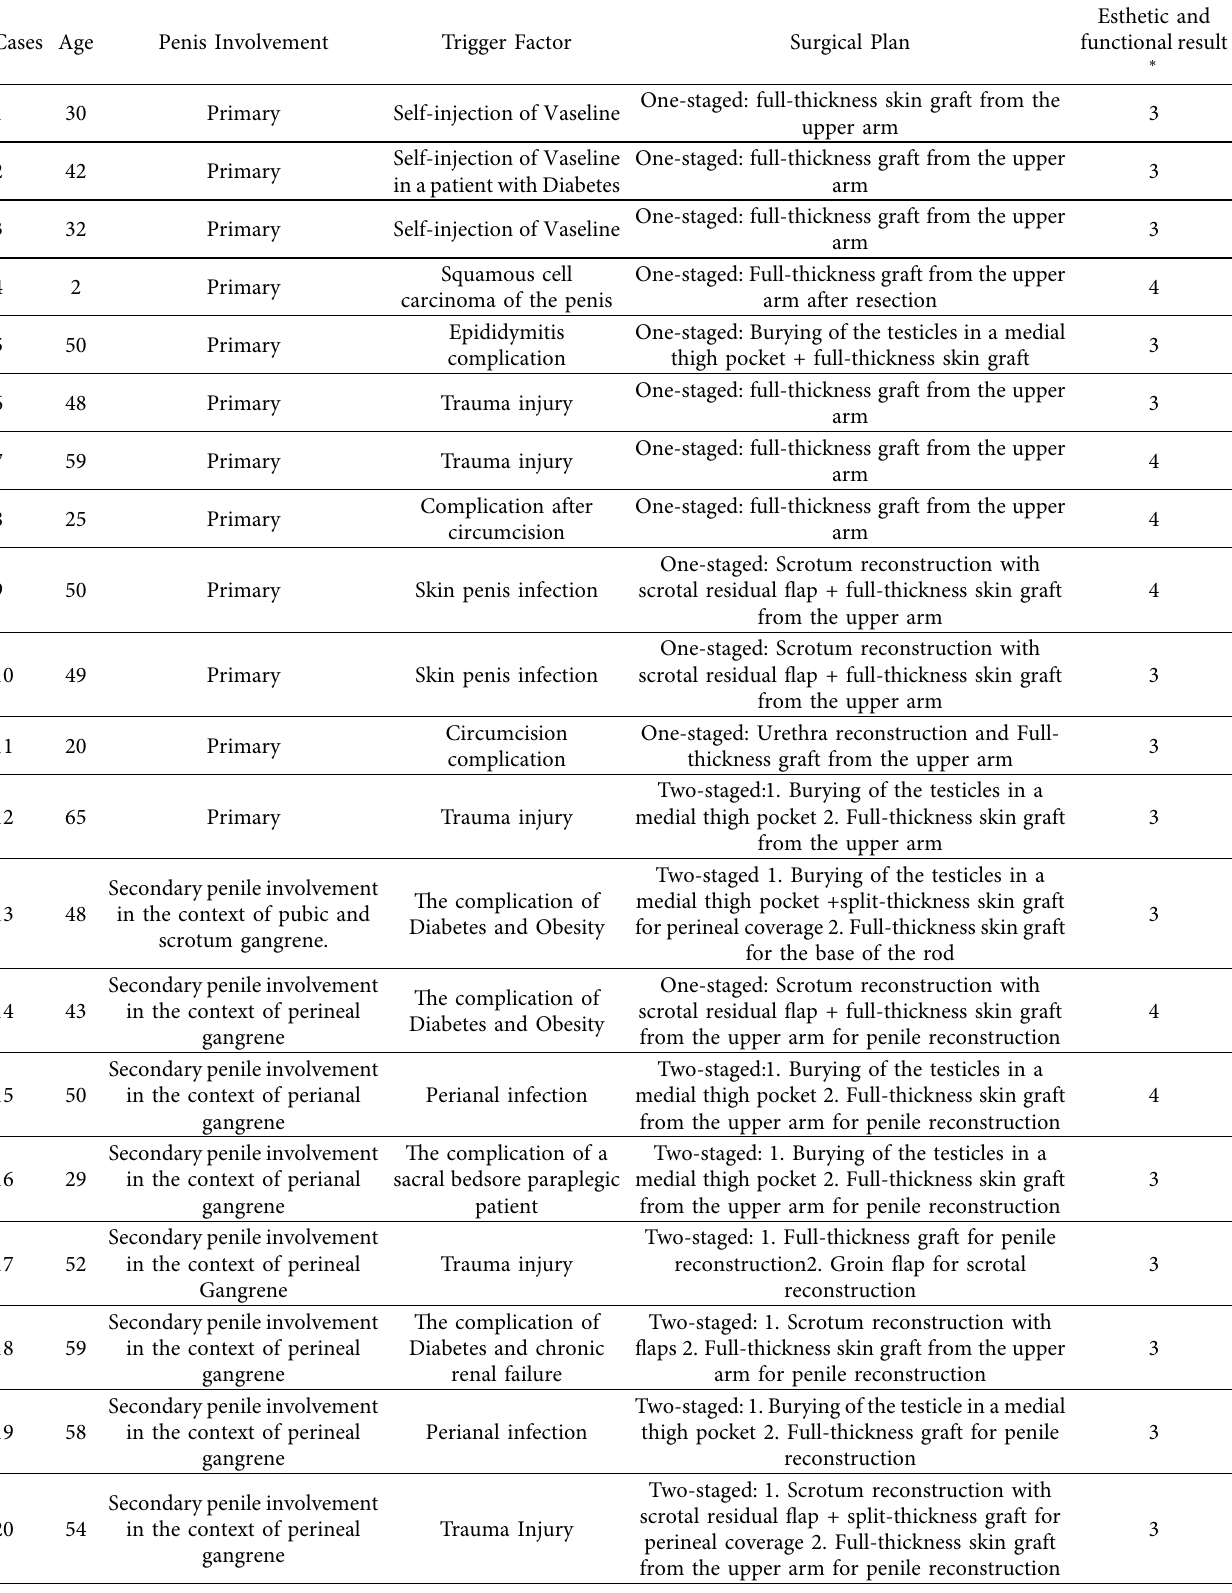
Table 1: Surgical management of our cases. ∗ Likert scale (1 � Poor; 2 � Sufficient; 3 � Good; 4 �